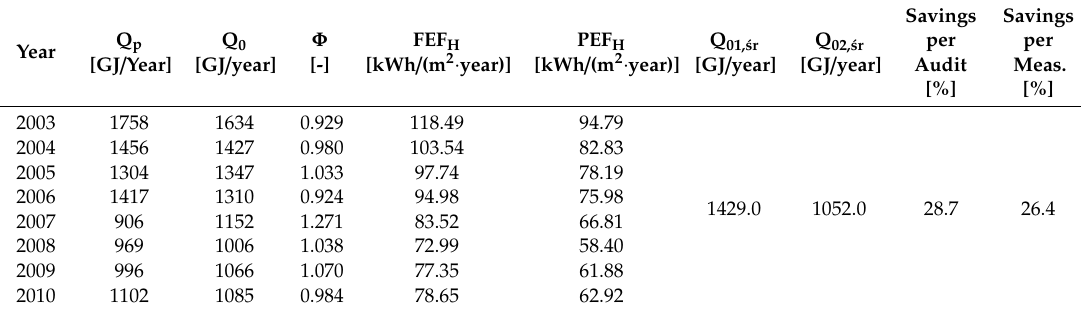
Table 4. Characteristics and heat consumption of an object from the group G2.